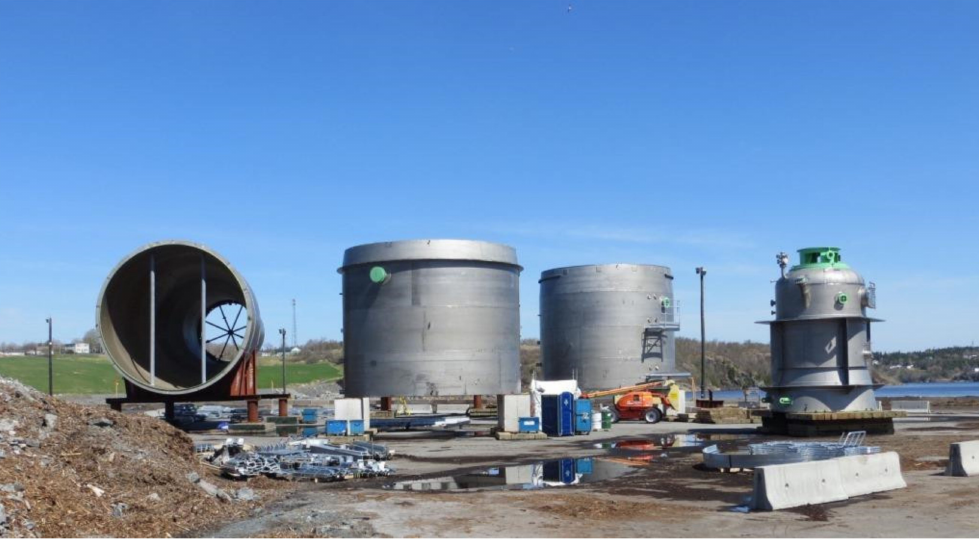
Figure 16. A 2304 digester and impregnation vessel digester for a Canadian Kraft pulp mill awaiting assembly. Photo courtesy of Steve